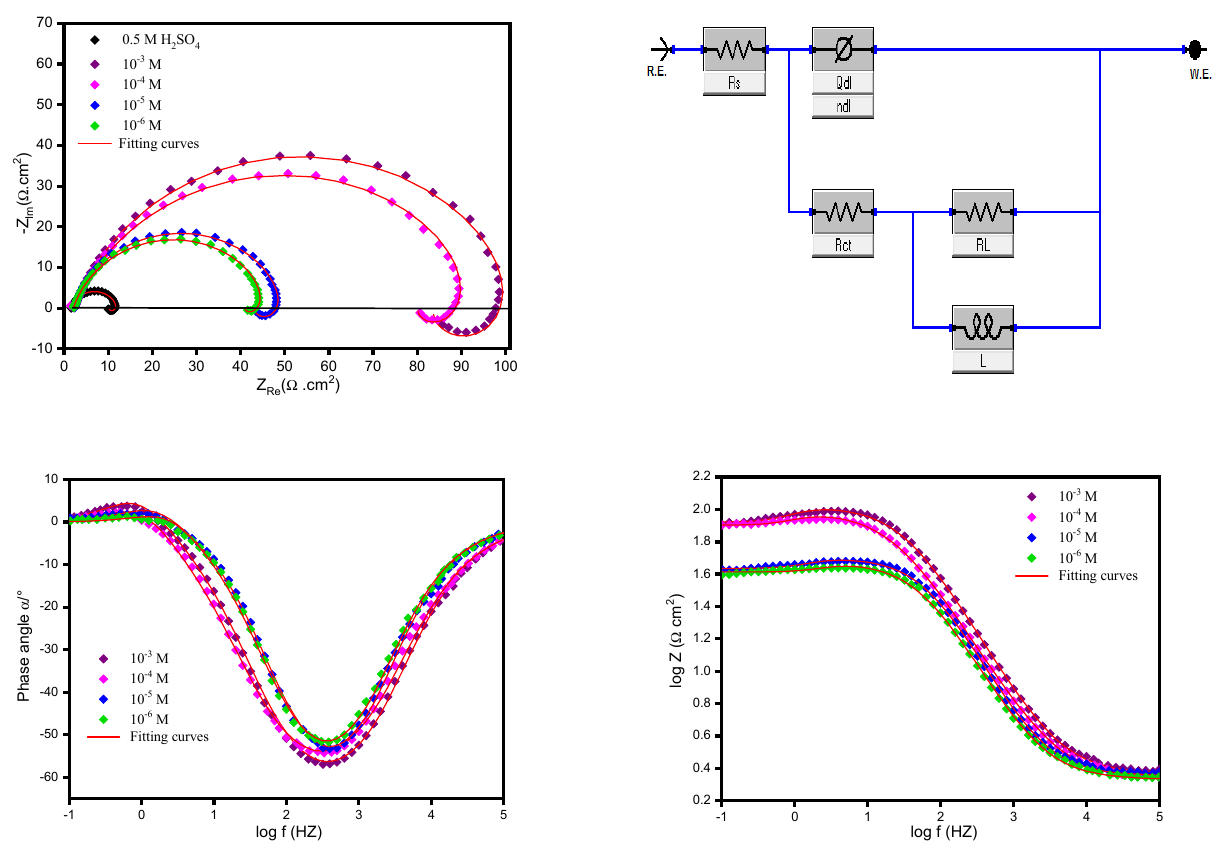
Figure 2. Nyquist and Bode plots and EC for MS immersed in 0.5 M H 2 SO 4 , uninhibited and inhibited by inhibitory resin at different concentrations. Table 2. EIS parameters for MS immersed in 0.5 M H 2 SO 4 medium, uninhibited and inhibited by di ff erent concentrations of TGP.